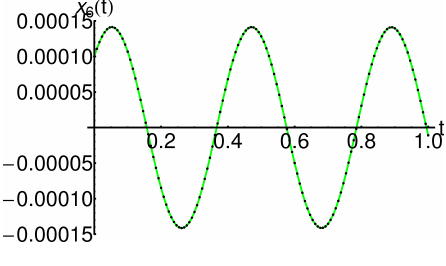
Fig. 6. Comparison between the approximate solutions ¯ x 6 given by Eq. (33) and the corresponding numerical solutions